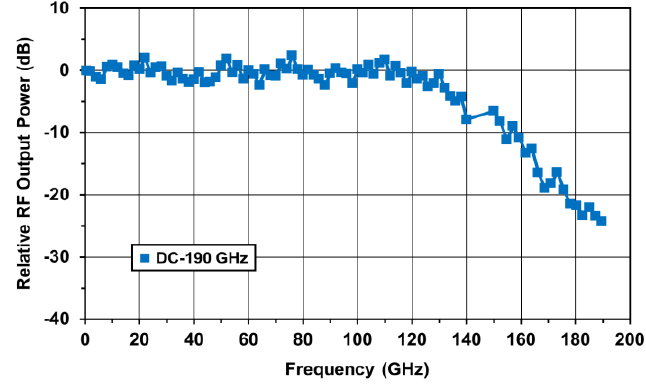
Figure 9. Measured relative RF output power from DC up to 190